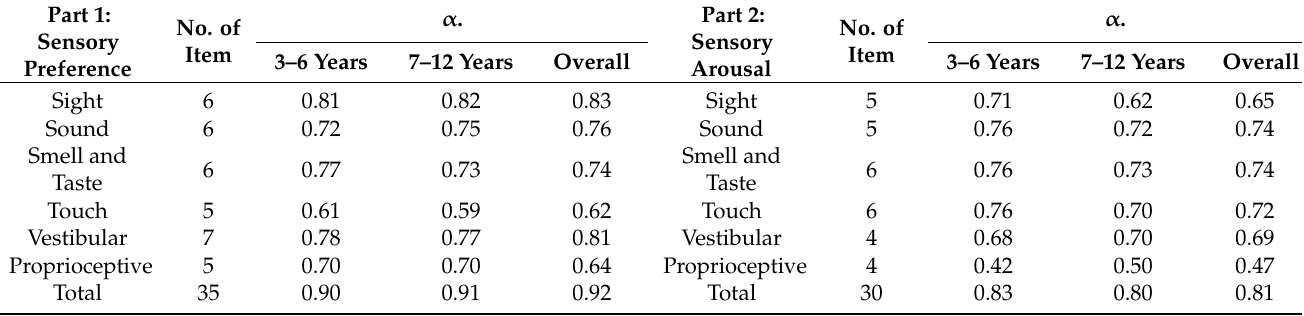
Table 4. Internal consistency after items were removed from the factor